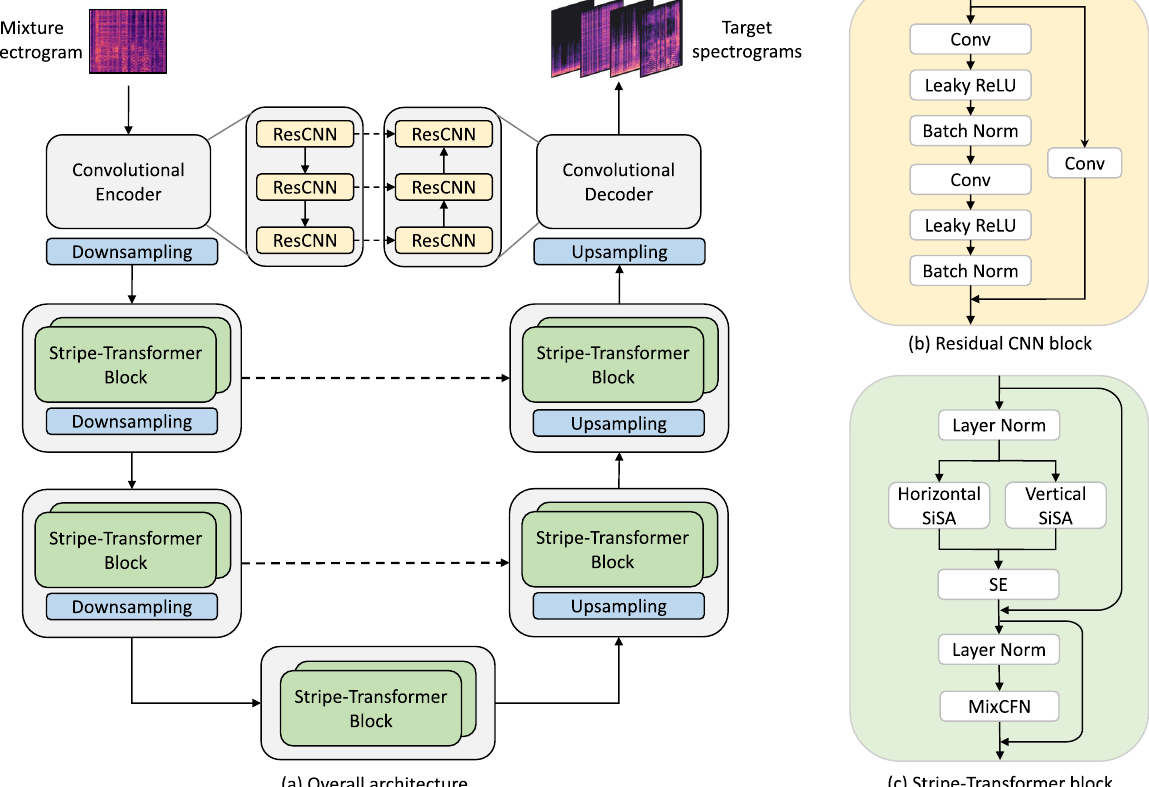
Fig. 2 The overall architecture of the proposed model and the detail of residual CNN and stripe-Transformer